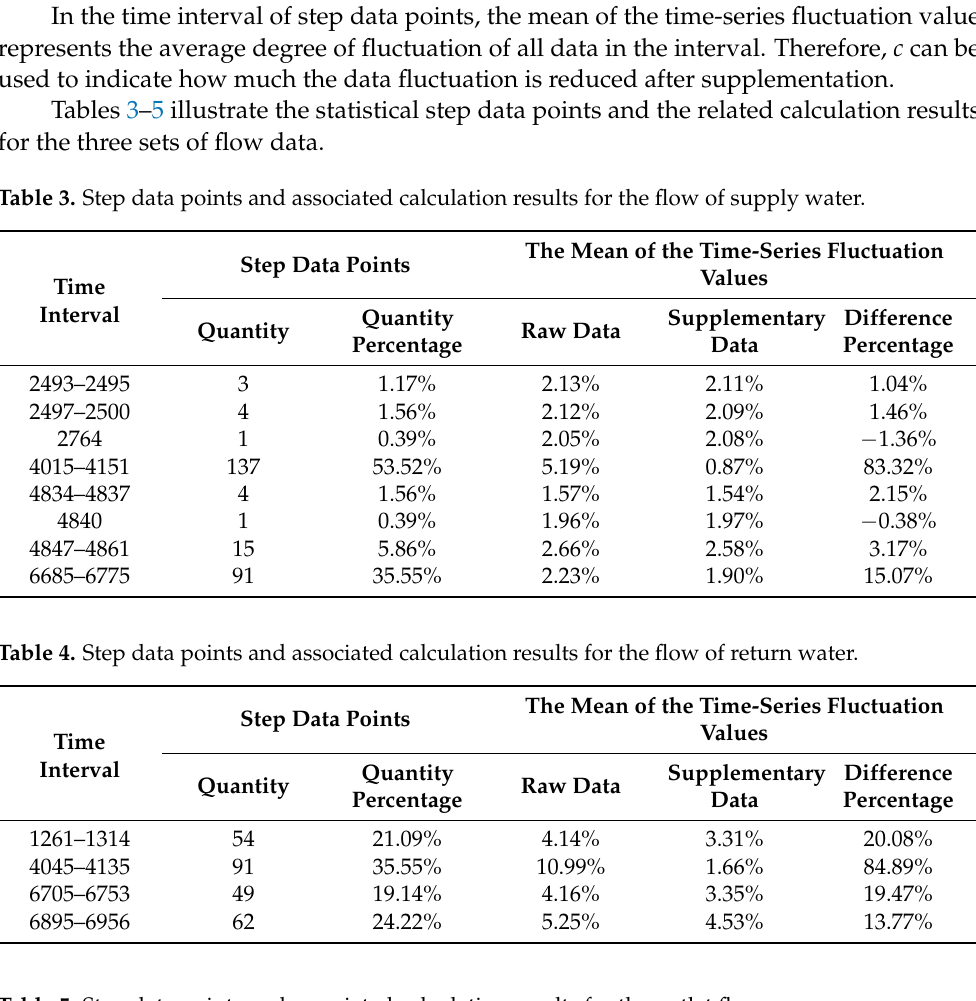
Table 5. Step data points and associated calculation results for the outlet